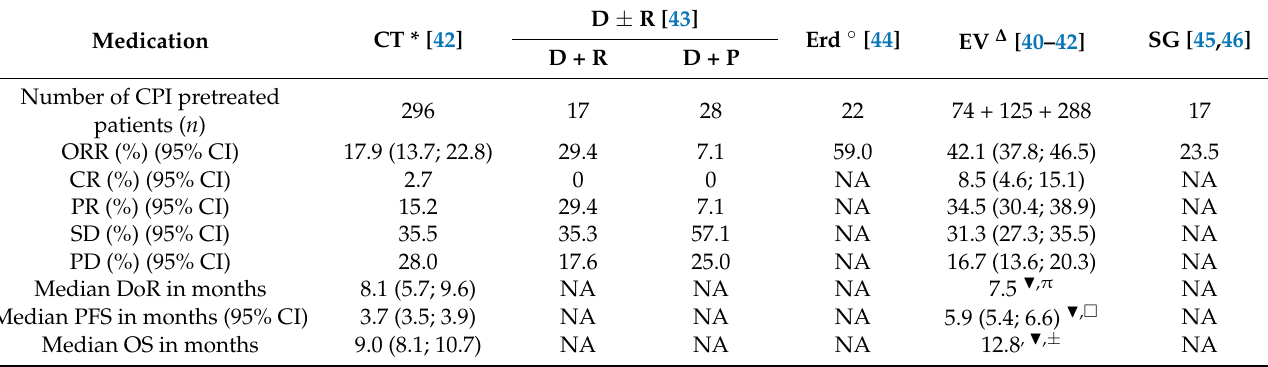
Table 2. * Paclitaxel, Docetaxel, Vinflunine. ◦ Selected regimen collective, treated with 8 mg of Erd continuously. ∆ Pooled data, all patients with prior CPI therapy treated with 1.25 mg EV/kg body weight available for response evaluation. (cid:72) Estimated using the plots of Kaplan-Meier. π n = 33 [40] + 55 [41] + 117 [42].